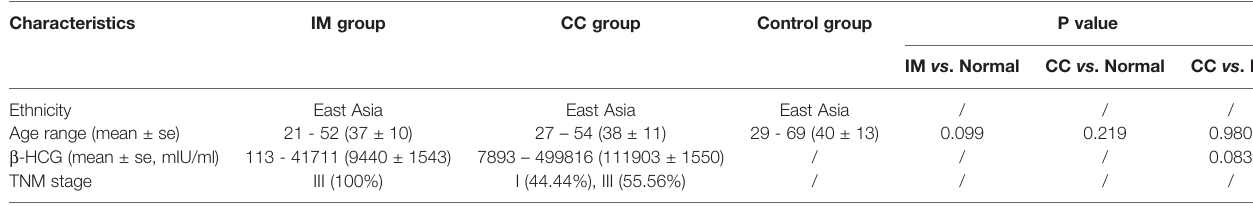
TABLE 1 | Summary of clinical information in each group and statistical analysis.